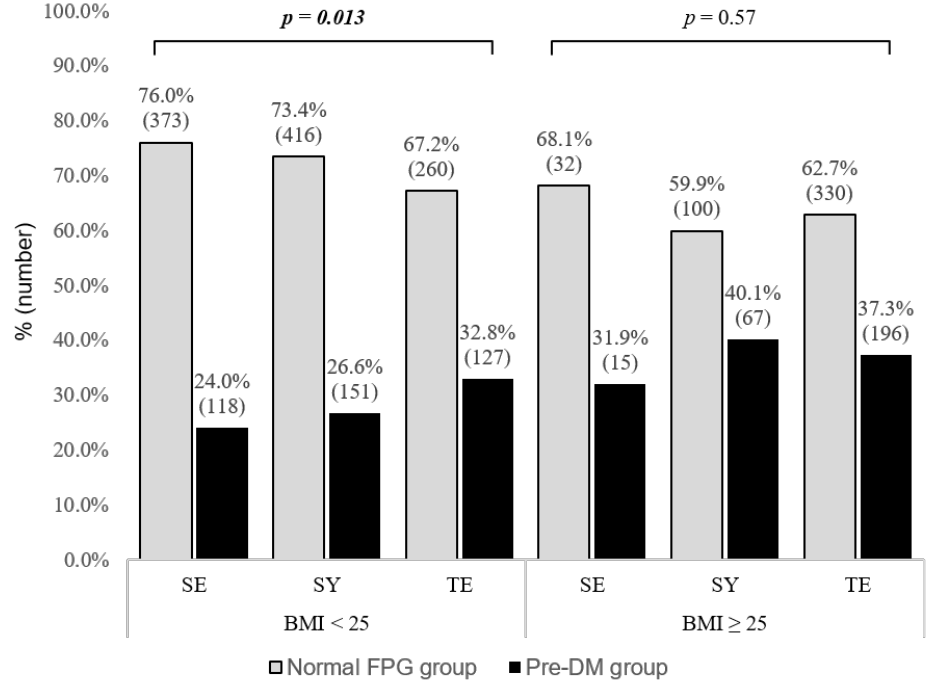
Figure 2. Proportion of individuals with pre‑DM by SC type according to BMI. BMI: body mass index, SE: Soeumin, SY: Soyangin, TE: Taeeumin, FPG: Fasting plasma glucose. Boldface type indicates statistical significance. Table 3. Adjusted ORs (95% CI) of the SY and TE types compared with those of the SE type for pre‑DM considering